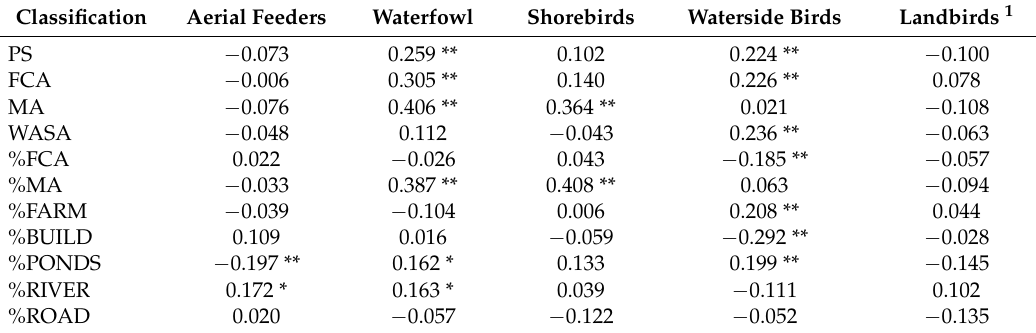
Table 4. Pearson product–moment correlation coefficients indicating the coefficients between guild species richness and pondscape variables.